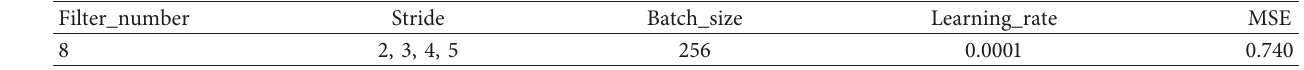
Table 2: The information of parameter settings.